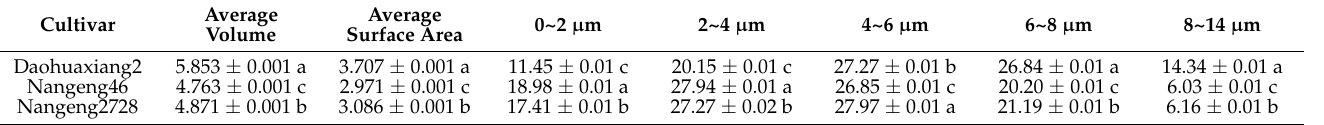
Figure 3. Starch particle size distribution of different japonica rice. Table 5. Differences of starch particle size distribution among different japonica